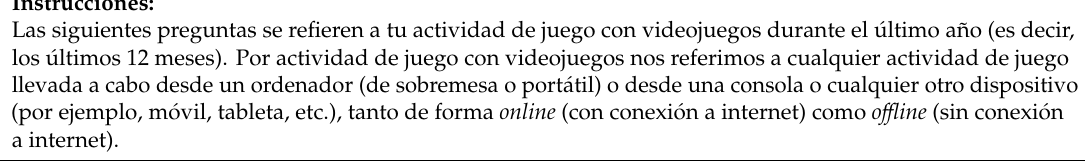
Table A1. Spanish version of the IGDS9-SF (Internet Gaming Disorder Scale-Short Form).